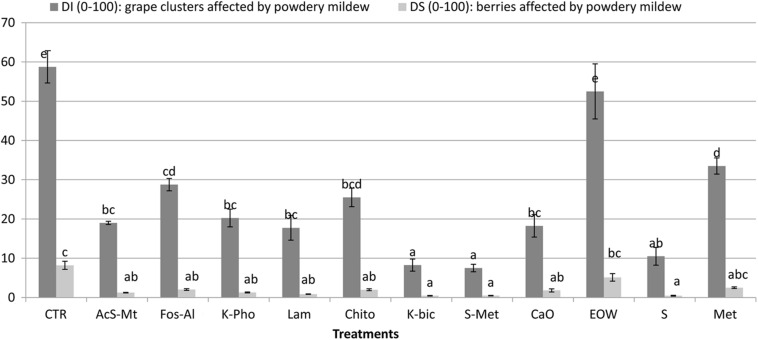
Efficacy of the treatments against Erysiphe necator on the incidence and severity on grape clusters, compared to non-treated control (CTR) and standard treatments for conventional (S+Met) and organic (S) farms in the region. Different letters mean significant differences (p < 0.05). Treatment descriptions are reported in Table 1.